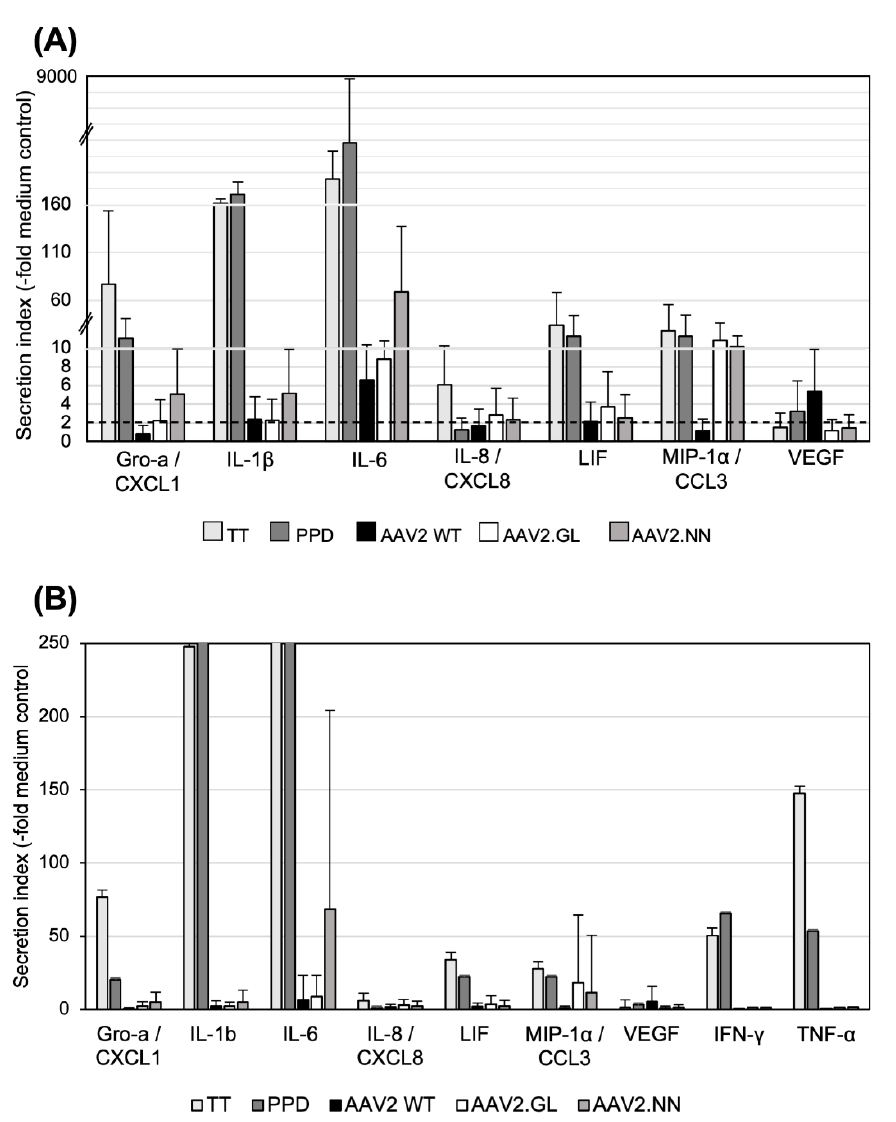
Figure 4. Cytokine secretion after in vitro stimulation with AAV vectors. ( A ) Innate cy- tokines/chemokines secreted by PBMCs stimulated in vitro. Pooled supernatants from three daily collections of stimulated PBMCs ( n = 5; H1, H2, H5, H6, H7) were tested. Data are shown as mean “secretion indices” ± SD calculated as fold stimulation in cultures with TT, PPD, or AAV2 capsids as indicated and calculated from the secretion in cultures with medium only. The solid line marks the secretion index of 2. Note the different scales of the y-axis; transitions are marked by the dashed lines. ( B ) Same as ( A ), but with higher magnification of the y-axis to show the high variation in the cytokine responses among the different donors. No significant differences were observed between the AAV capsids. Statistics were performed using the Friedman test and Dunn ´ s Multiple Comparison test; no significant differences were observed.